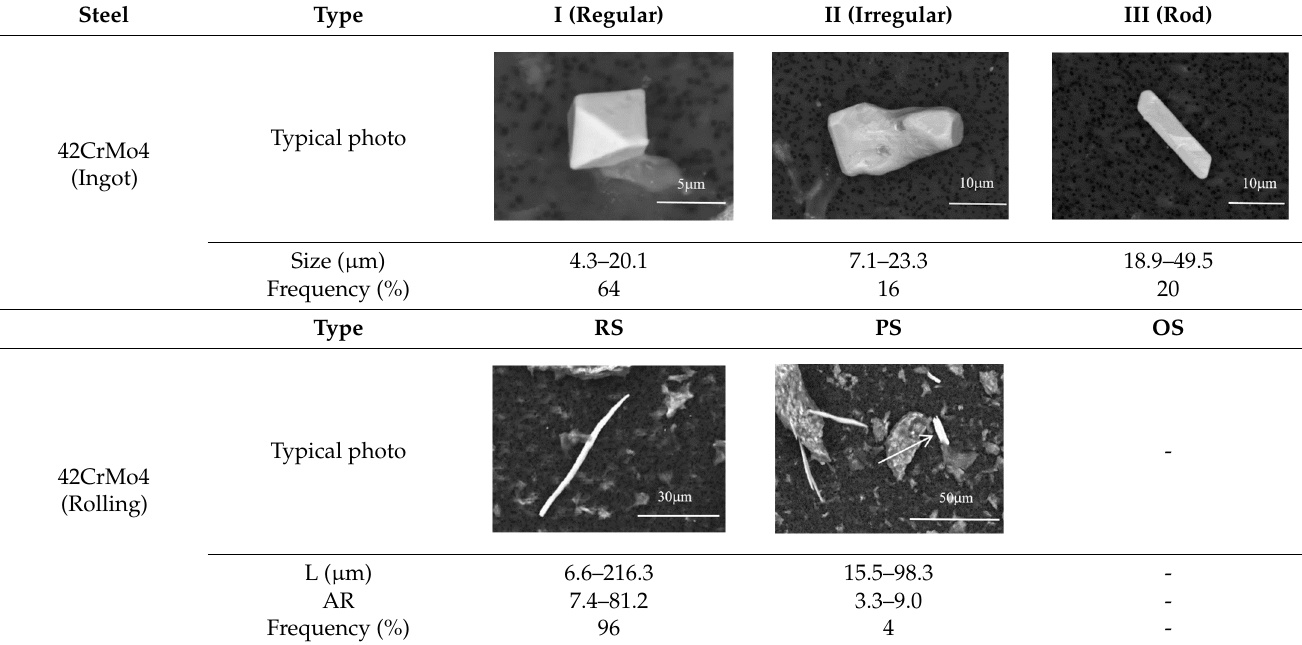
Table 9. Main parameters of EE and SEM observations of elongated sulfides in different steel sam- ples of 42CrMo4 steel grade after heat treatment using Method 2.